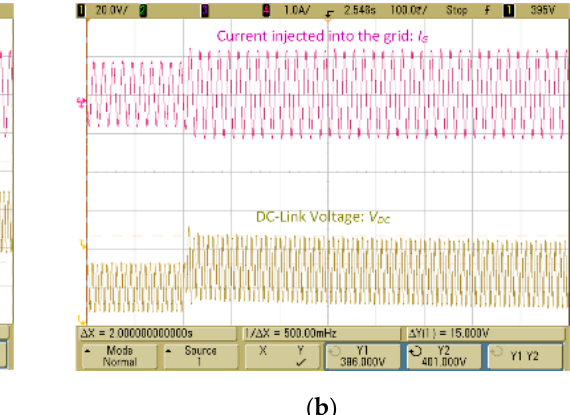
Figure 11. Experimental setup.